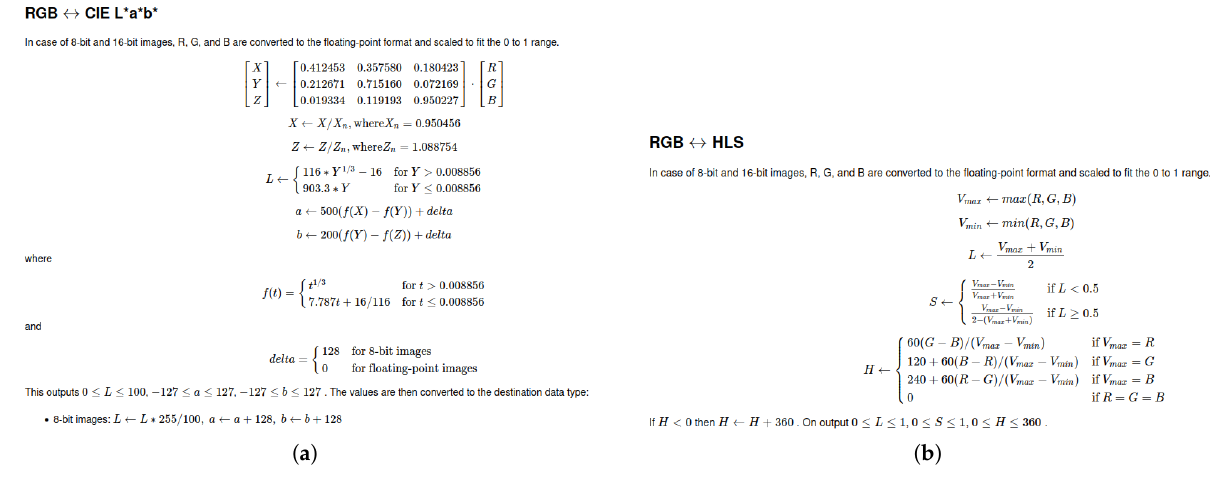
Figure 6. Mathematics behind the color conversion from RGB to CIELAB and RGB to HLS. Images sourced from [23].